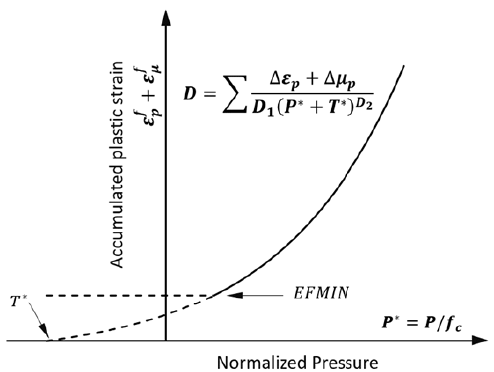
Figure 6. Damage evolution in the stress – strain space of the HJC material model. EFMIN is the minimum plastic strain in Figure 6. The damage variable ( D ) in the HJC model is defined as follows.